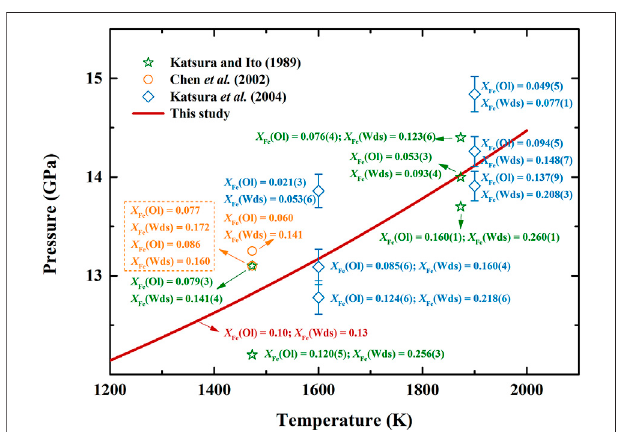
FIGURE 6 | phase transition boundary of olivine-wadsleyite in (Mg,Fe) 2 SiO 4 systemfromthisstudy,andpreviousresultsinMg 2 SiO 4 system. Red solid line: this study; Blue dash line: Morishima et al. (1994); Blue dash- dot line: Jacobs et al. (2006); Blue short dash line: Akaogi et al. (2007); Blue dot line: Ottonello et al. (2008); Orange dash line: Holland and Powell (2011); Yellow dash-dot line: Dorogokupets et al. (2015).